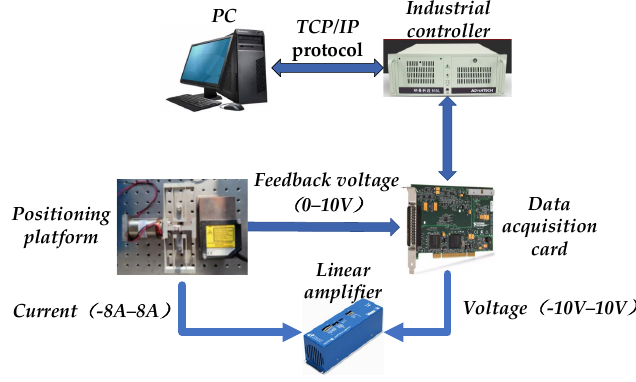
Figure 1. The micro-positioning platform.